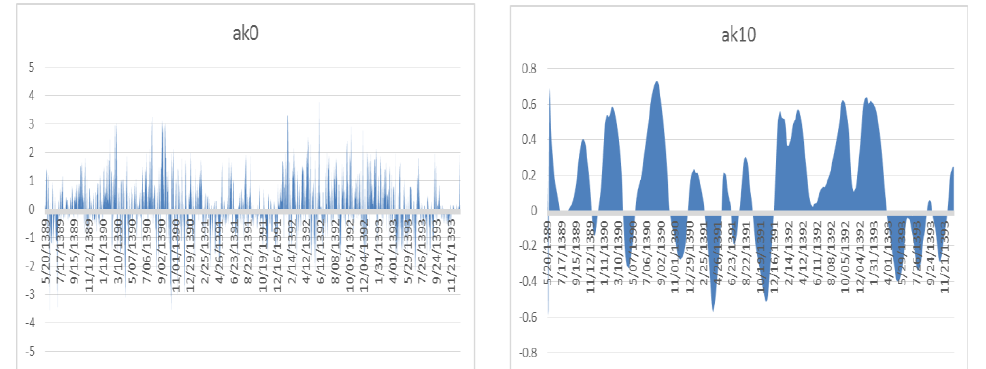
Figure 5. Original series and long-term series of Beta of car